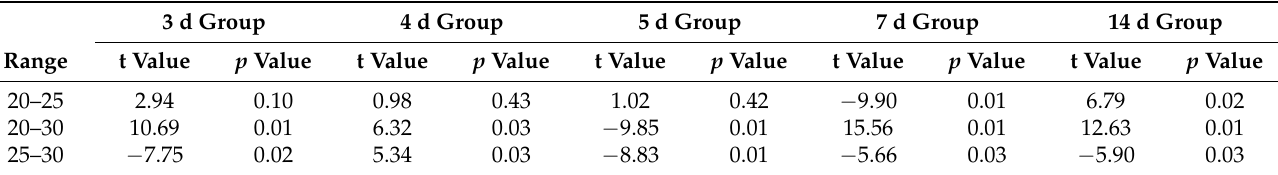
Table 9. Post hoc multiple comparisons (temperature).